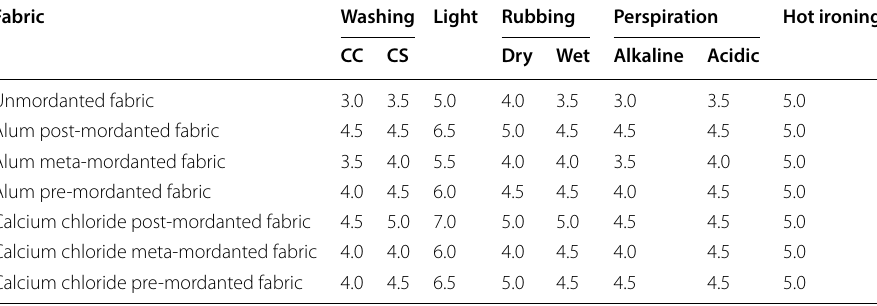
CC color change, CS color stain